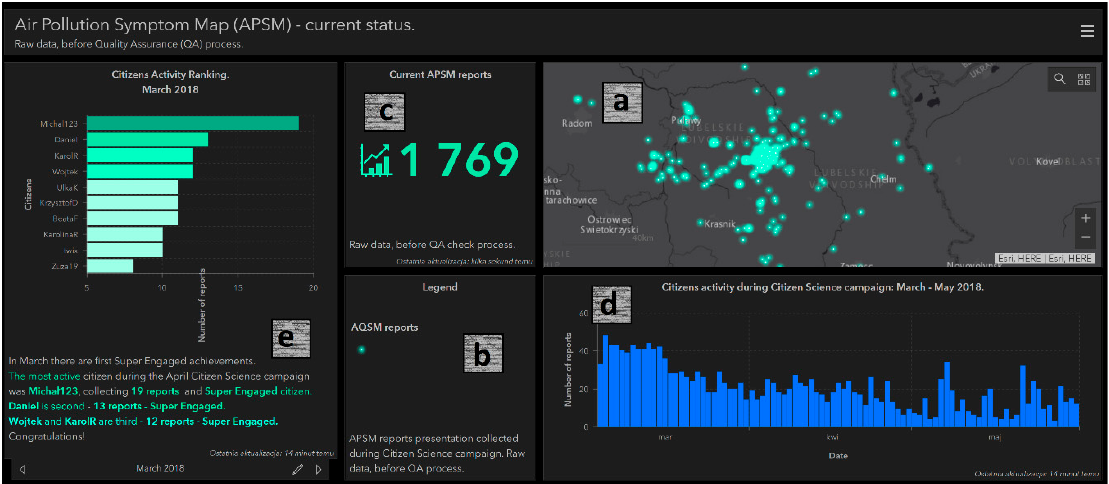
Figure A4. Web mapping application operations dashboard, presenting collected data (before QA check) in real time: ( a ) map, ( b ) legend, ( c ) indicator of current number of the reports, ( d ) citizen activity histogram, and ( e ) citizen activity rank- ing.